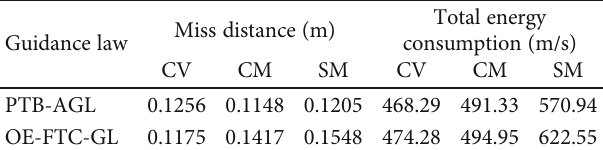
Table 7: RMS values of Monte Carlo results — Case 2. Miss distance (m) Guidance law